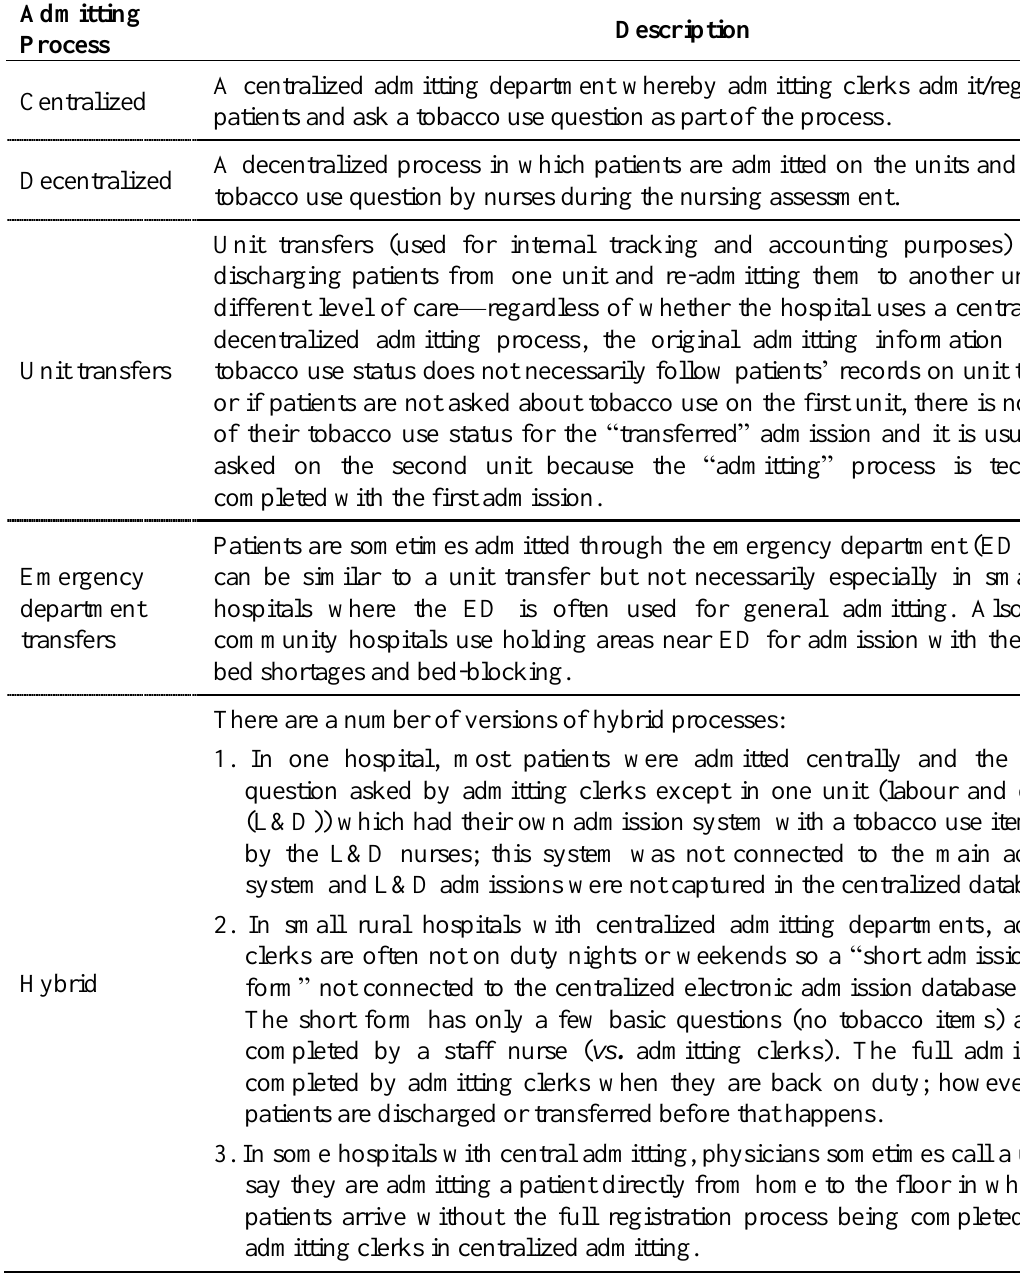
Table 2. Varying hospital admitting